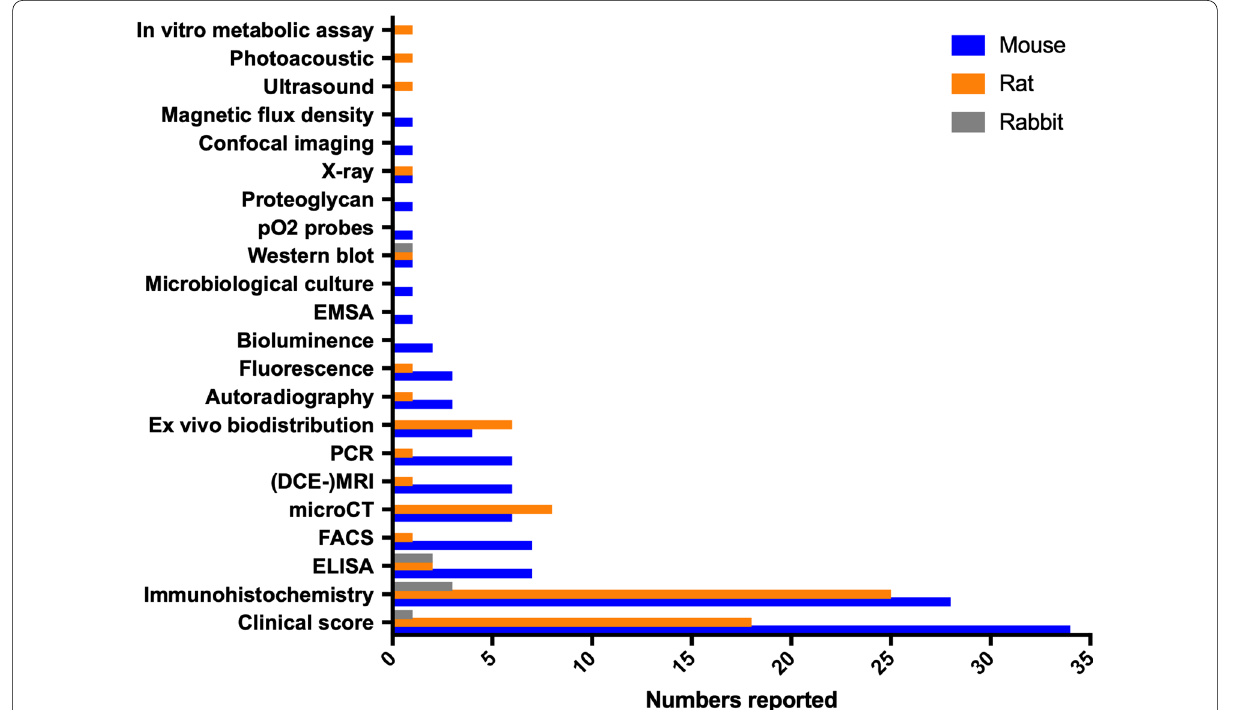
Fig. 6 Modalities employed as read‑out for imaging findings. EMSA stands for electrophoretic mobility shift assay